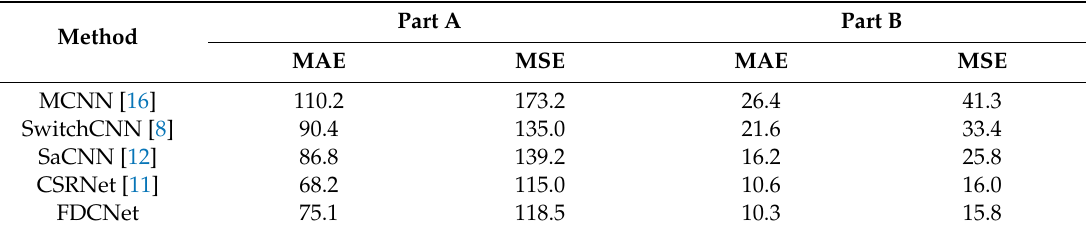
Table 2. The estimation errors on ShanghaiTech